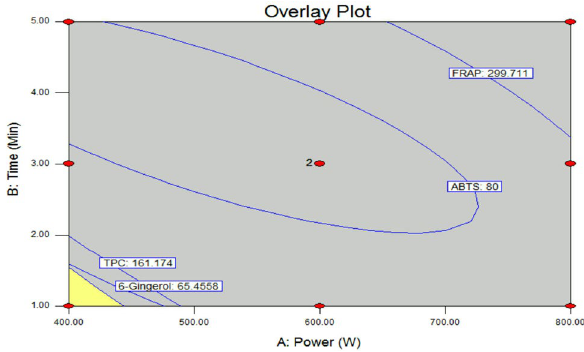
Figure 2. Overlay plot for the optimal conditions for microwave-assisted ginger extraction.